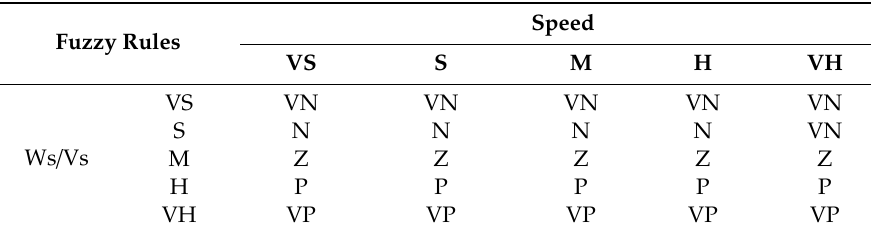
Table 2. Table of rules for the fuzzy controller.